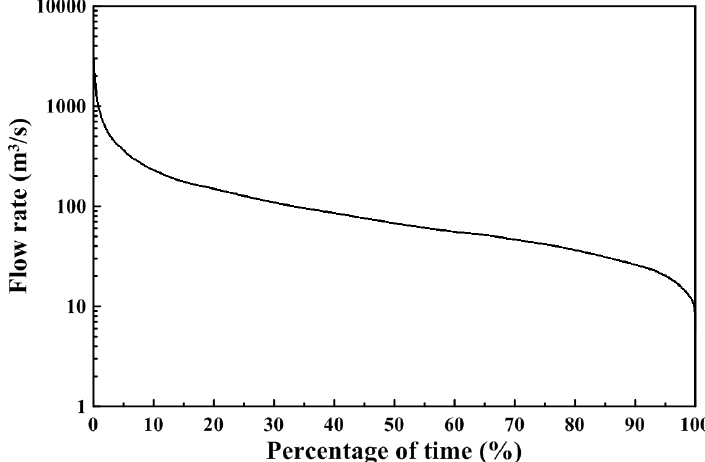
Figure 9. Flow duration curve at Dadu Bridge.